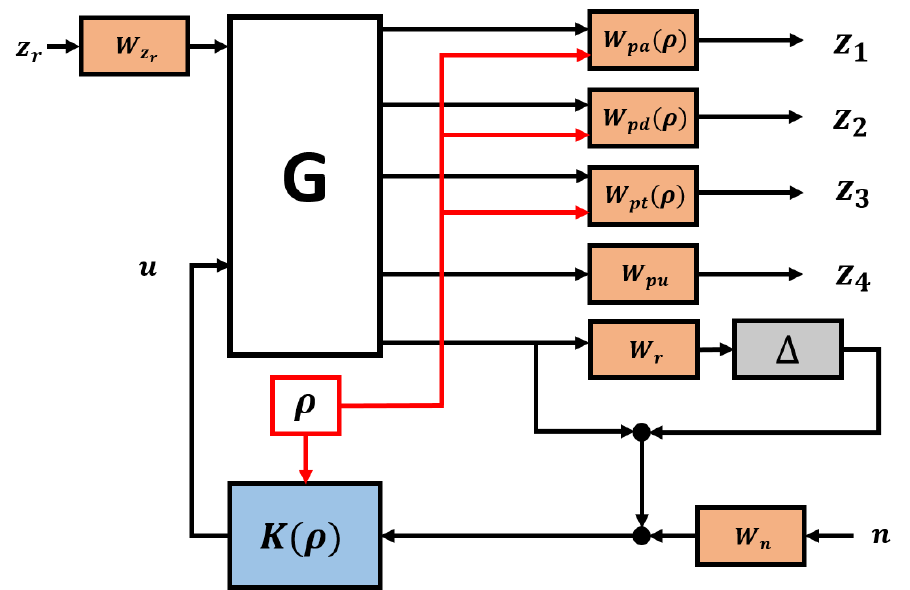
Figure 3. Closed-loop interconnection structure of semi-active suspension